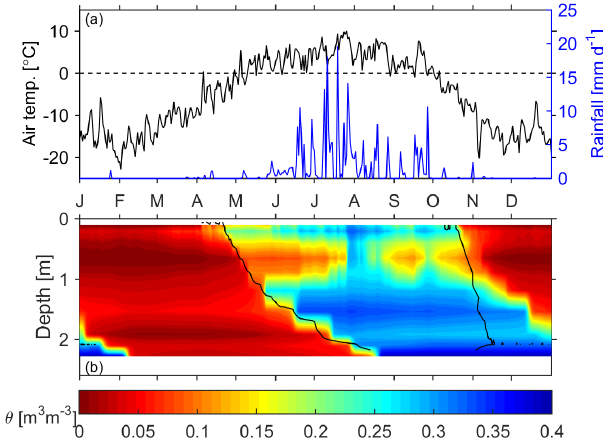
Figure 5. Typical dynamics of the active layer during an annual cy- cle (data from 2008). (a) Daily mean air temperature and daily rain- fall. (b) Liquid water content (colours) and 0 ◦ C-isotherm (black